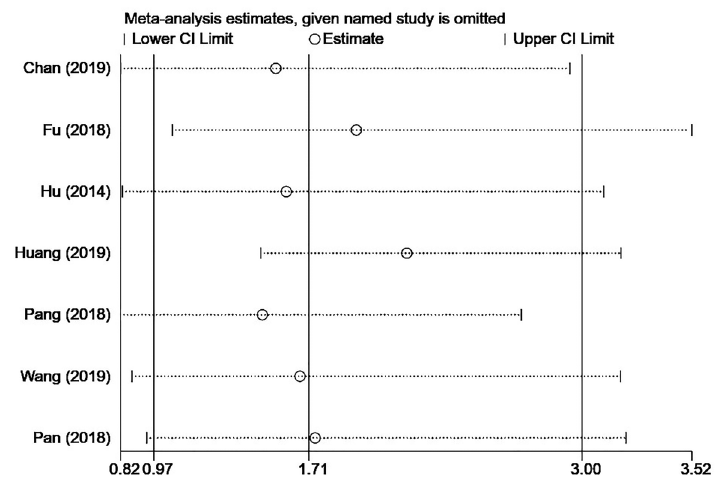
Figure 4. Sensitivity analysis of the relationship between preoperative systemic immune-in fl ammation index and vascular invasion. See Supplementary Table S2 for reference numbers.